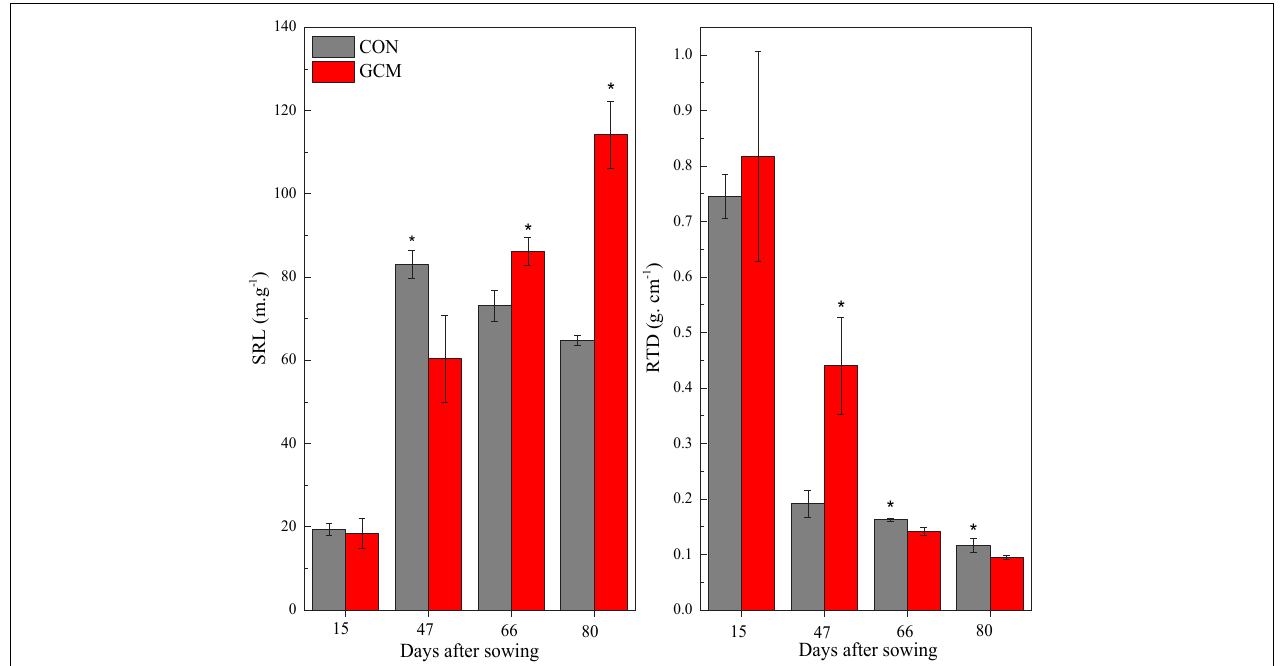
FIGURE 2 | Specific root length (SRL) and root tissue density (RTD) of oat in CON and CMD treatments at various stages. 15 days after sowing corresponds to the plant trefoil stage; 47 days after sowing corresponds to the plant elongation stage; 66 days after sowing corresponds to the plant pustulation stage; 80 days after sowing corresponds to the plant maturity stage. CON, control; CMD, cattle manure deposition. Data represents mean ± SE ( n = 3). The data was based on a pot experiment in one year. All parameters were analyzed with SPSS version 16.0 (SPSS Inc. Chicago, IL, United States). Differences between CON and CMD treatments in each root trait at various growth stages are indicated (* represents P < 0.05).